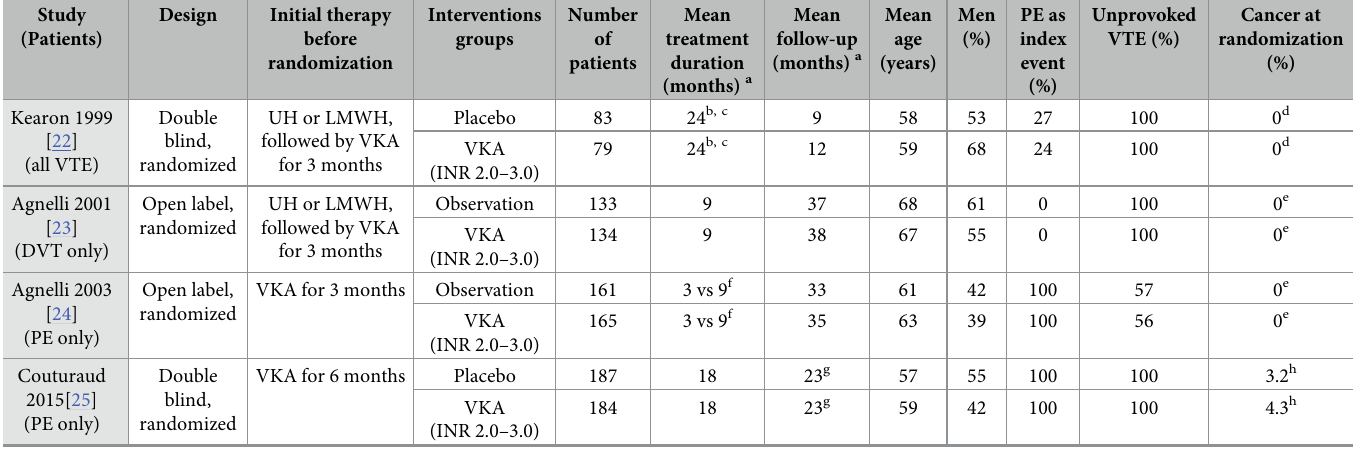
Table 1. Baseline characteristics and results of included